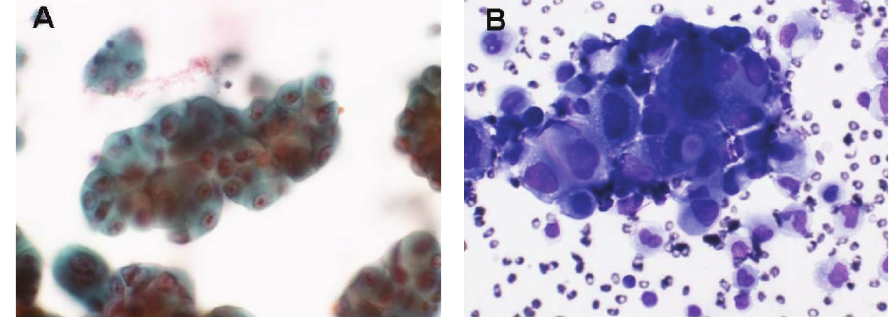
Figure 3: Adenocarcinoma cells in the pleural effusion. (A) Papanicolaou stain. (B) May-Giemsa